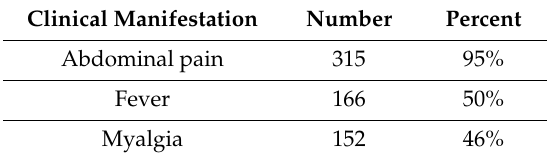
Table 1. Distribution of the most common symptoms among